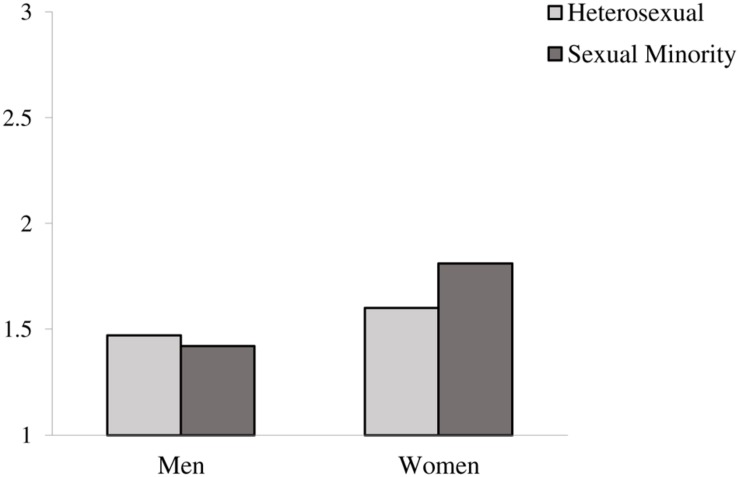
Interaction of gender and sexual orientation on workplace incivility.